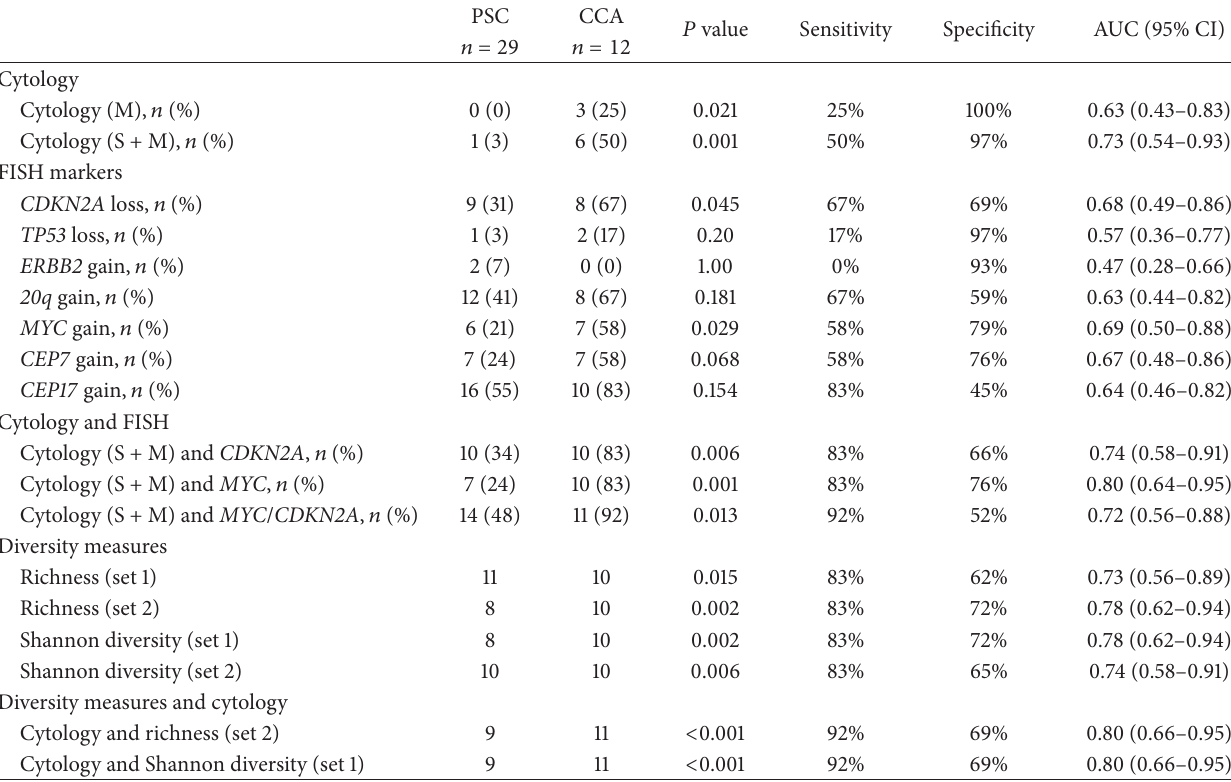
Table 2: Diagnostic performance of cytology, FISH, and measures of clonal diversity in distinguishing benign from malignant strictures. PSC CCA 𝑃 value